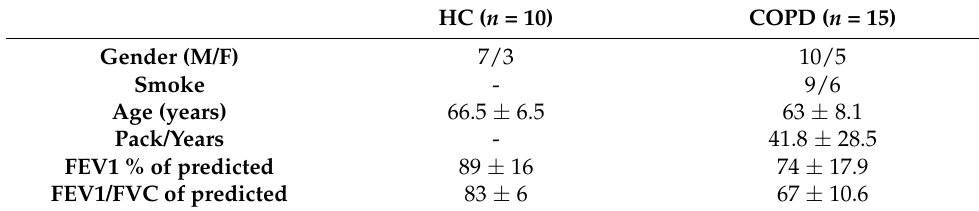
Table 1. Demographic characteristics of the subjects.